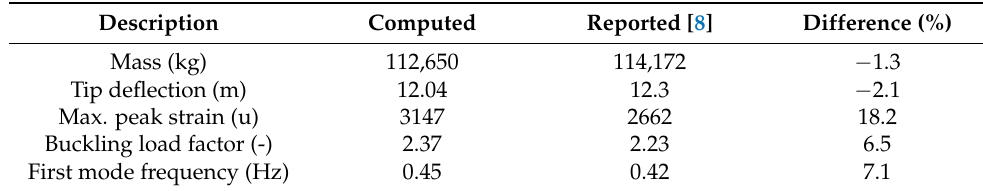
Table 2. Blade model verification for DLC